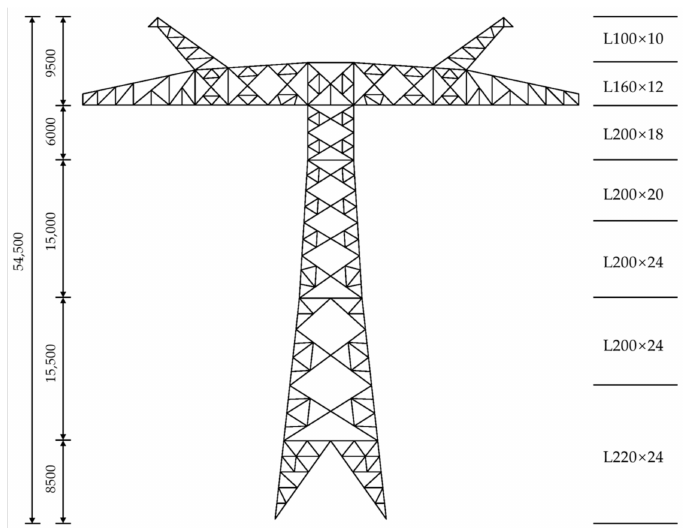
Figure 1. Tower dimensions (unit: